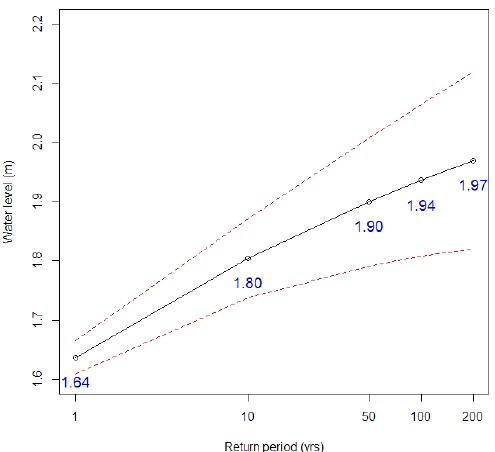
Figure 6. Results of Method 1 applied to observed flood level data at Barrack Street gauge near location Sw10. The black line repre- sents estimated flood levels. The red dashed lines indicate the 95% confidence